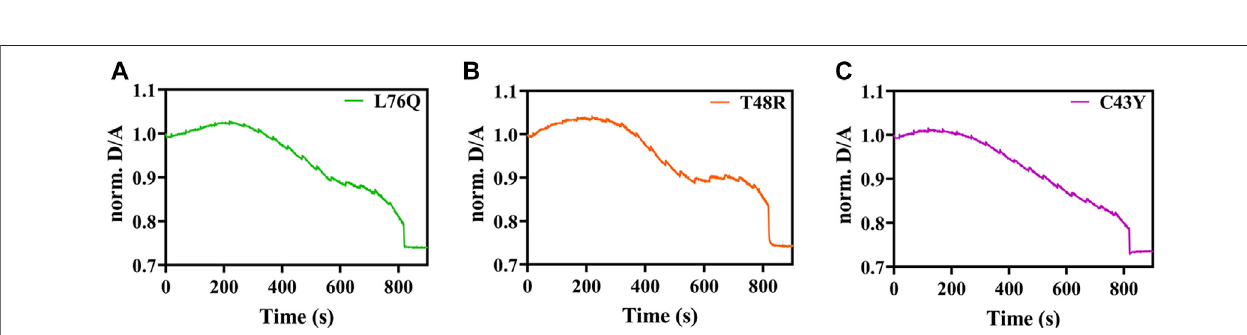
FIGURE 3 | Exemplary temperature-induced thermal unfolding curves of the L76Q, T48RM, and C43Y mutants are visible in Figures 3A – C , respectively.